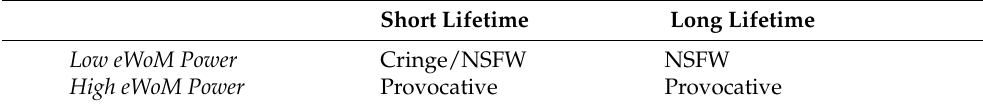
Table 13. Categorization of the posts associated with the lifespan template